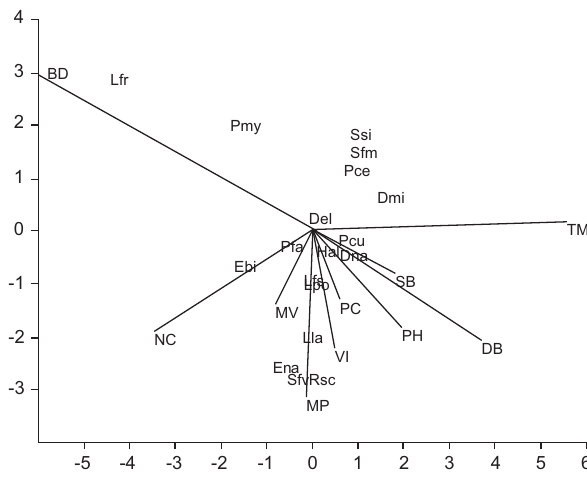
Figure 4. Canonical Correspondence Analysis (CCA) for species com- position in the six breeding ponds sampled from September